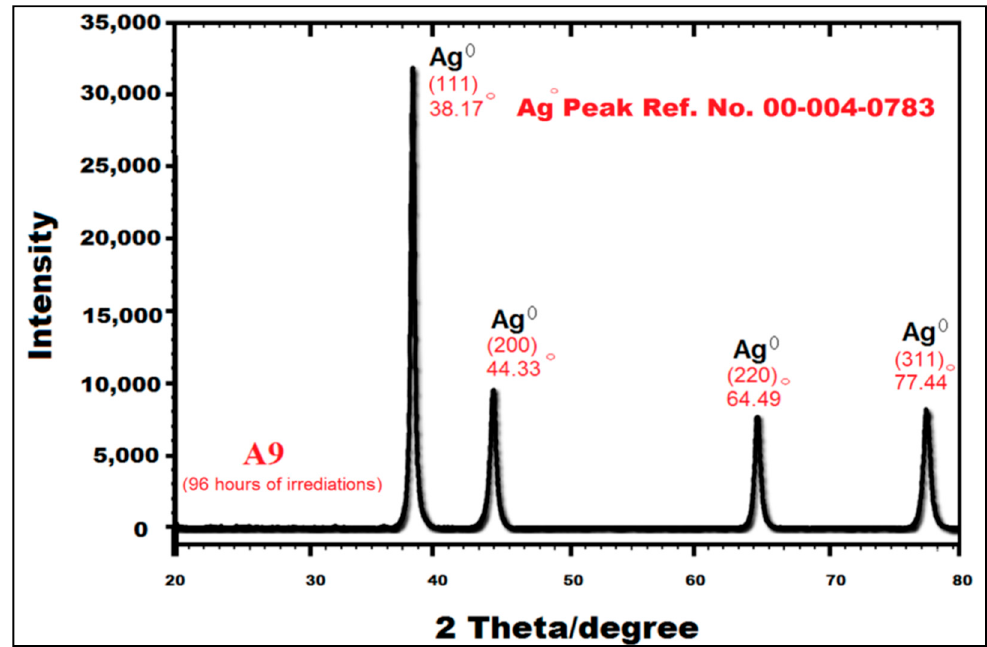
Figure 3. Powder X-ray diffraction (PXRD) spectra for P-AgNPs obtained after 96 h of UV irradiation.